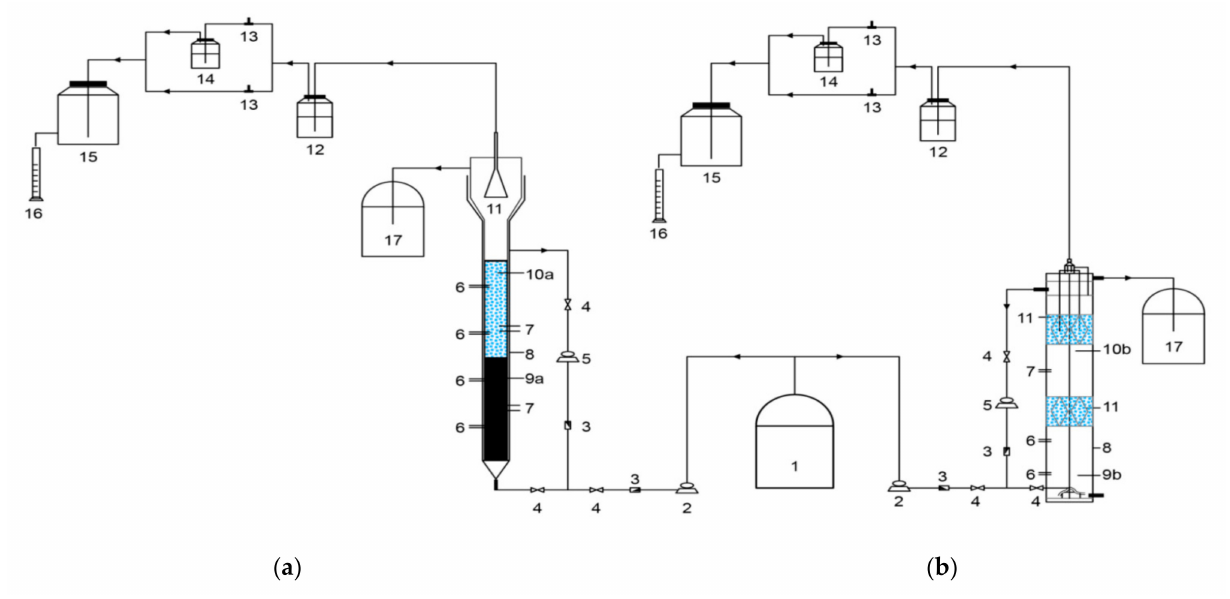
Figure 2. Flow chart of the combined experimental device of EGSB reactor and IC reactor. ( a ) EGSB, ( b ) IC. 1. Inlet bucket; 2. inlet pump; 3. rotor flowmeter; 4. control valve; 5. reflux pump; 6. sampling port; 7. feed port; 8. insulation material; 9a. sludge bed area; 9b. the first reaction zone; 10a. sludge settlement area; 10b. the second reaction zone; 11. three-phase separator; 12. water sealed bottle; 13. valve; 14. CO 2 absorption bottle; 15. Markov bottle; 16. graduated cylinder; 17. outlet